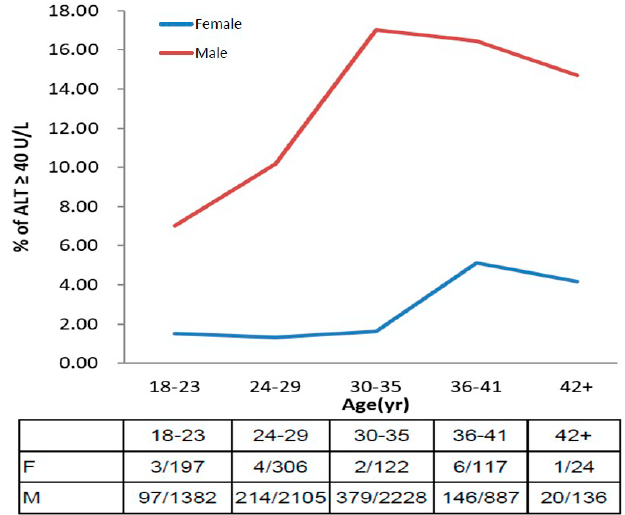
Figure 1. The age-based prevalence of elevated ALT in men and women.